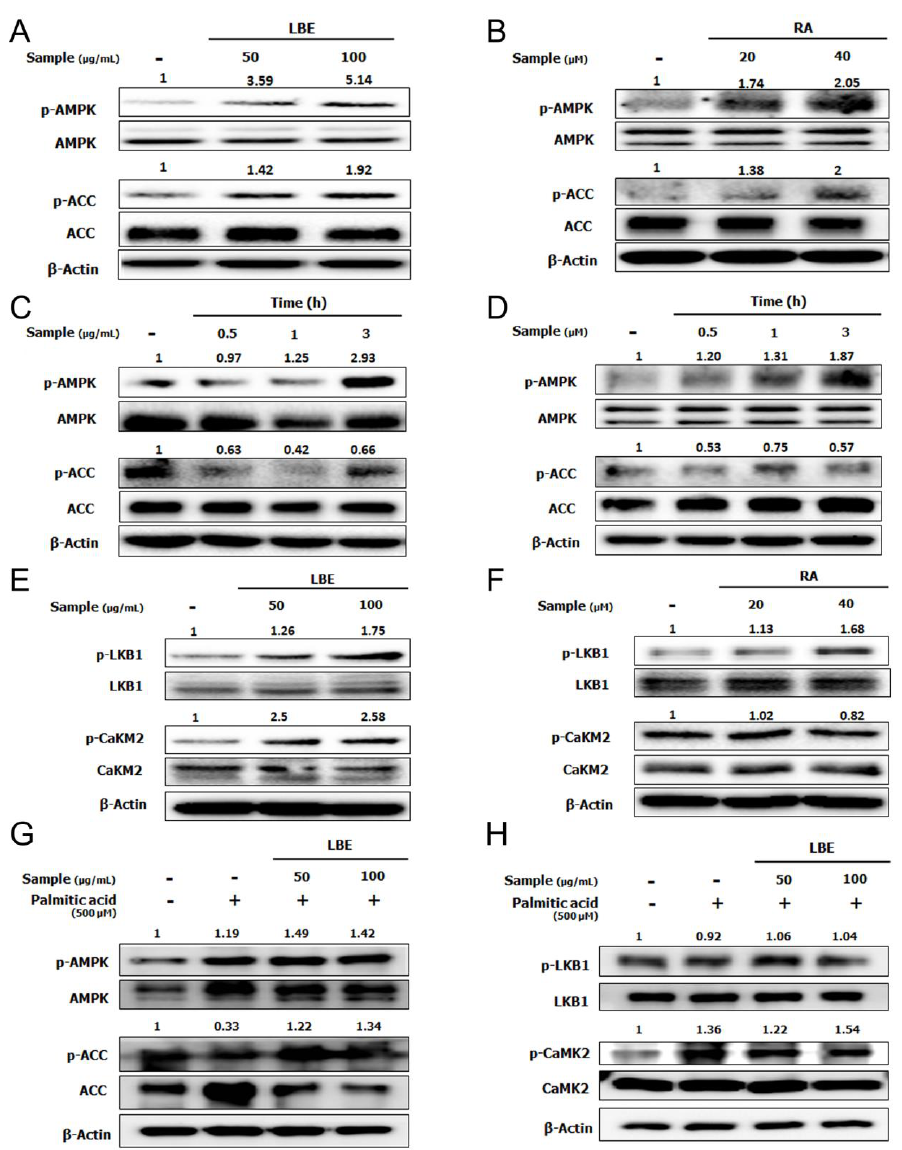
Figure 5. Effects of LBE and RA on AMPK signaling in HepG2 cells without PA. Activation of AMPK and acetyl-CoA carboxylase (ACC) phosphorylation by ( A ) LBE (50 or 100 µ g / mL) and ( B ) RA (20 or 40 µ M), and ( C ) 100 µ g / mL LBE for 0.5–3 h and ( D ) 40 µ M RA in for 0.5–3 h. Activation of liver kinase B1 (LKB1) and Ca 2 + / calmodulin-dependent protein kinase II (CaMKII) phosphorylation by ( E ) LBE and ( F ) RA. With PA, (G) activation of AMPK and ACC phosphorylation, and (H) activation of LKB1 and CaMK2 phosphorylation by LBE (50 or 100 µ g / mL). β -Actin was used as an internal control for western